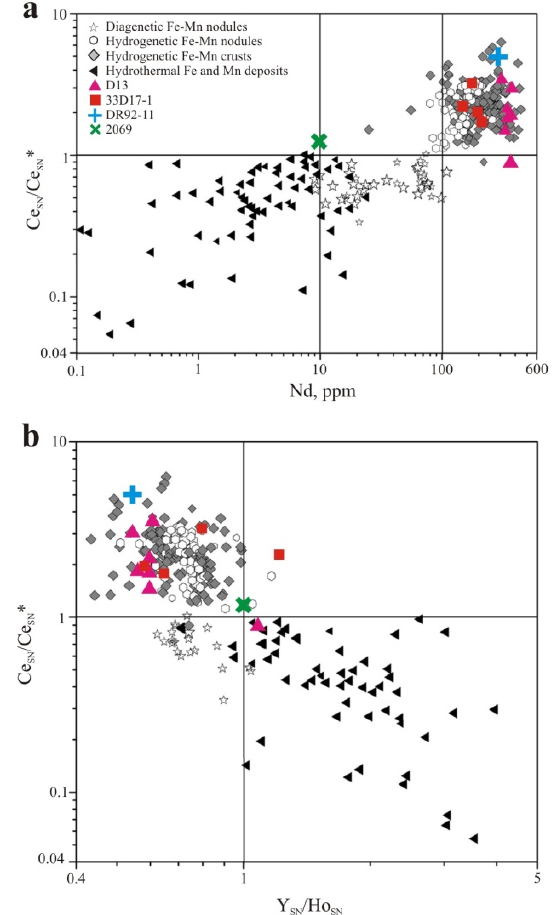
Figure 5. Marine Fe-Mn (oxyhydr) oxide deposits (own data) in graphs of ( a ) Ce SN /CeS N * ratio vs. Nd concentration and ( b ) Ce SN /Ce SN * ratio vs. Y SN /Ho SN ratio.